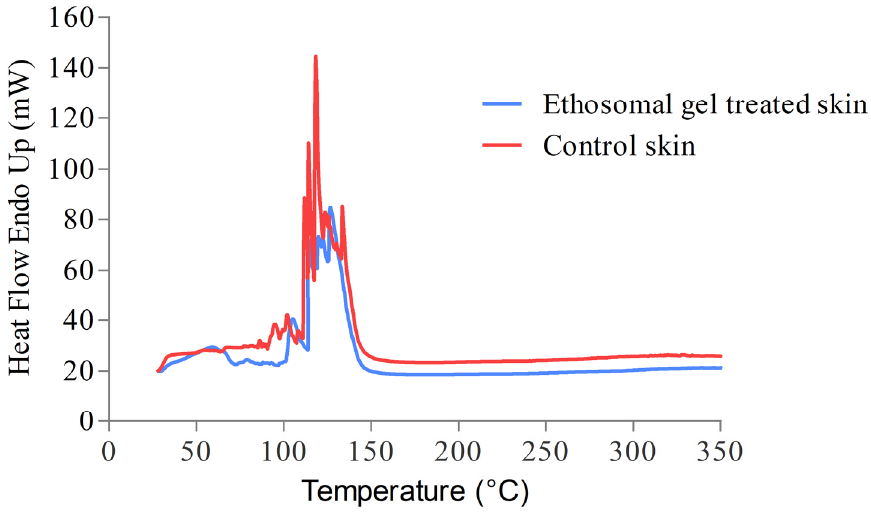
Figure 10. Comparative DSC thermogram between the control skin and ethosomal gel treated skin showing exothermic peaks corresponding to the phase transition of lipids present in the skin.